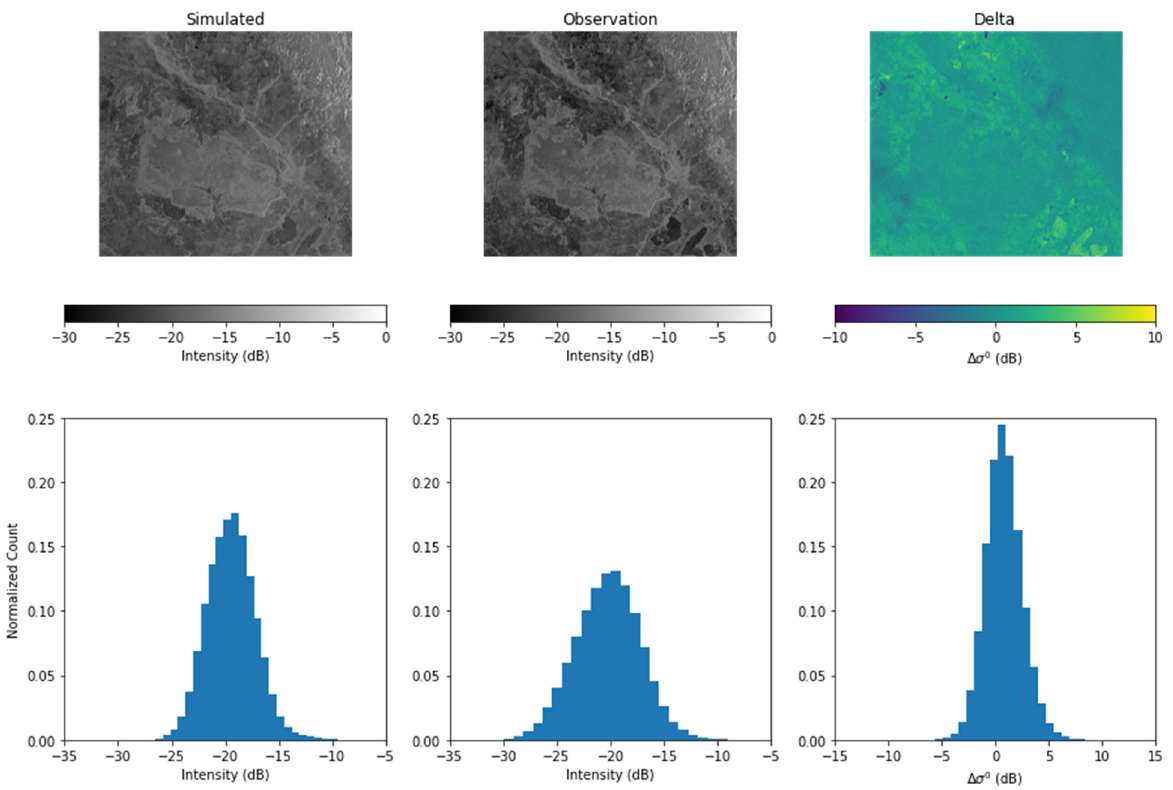
Figure 4. Simulated, real observation and Delta image with their respective histograms for VV po- larization. Real observation corresponds to 20 December 2017.